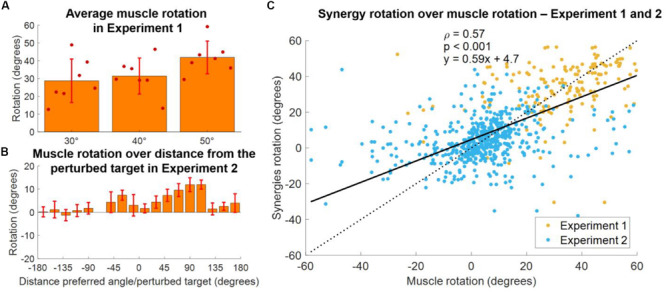
Comparison between synergies and muscle rotations. (A) Average (across muscles) rotation of the muscles at AD3 for all three macro-blocks of Experiment 1. Individual dots represent the average value for each subject in each experiment. Bars and whiskers represent the average and standard deviations across subjects. Muscle rotation was calculated using the same procedure employed for the calculation of the synergy rotation. (B) Distribution of average (across subjects, targets and muscles) muscles rotations values as a function of the distance between the preferred angles of the muscles and the perturbed targets for Experiment 2. Bars represent average values, whiskers standard deviations. (C) Synergies rotations over the rotations of the muscles contributing to each synergy (data of both experiments pooled together). A muscle was considered to contribute to a synergy if its weight in the synergy was above >0.4. The solid black line represents the linear fit between synergies and muscles rotations (values of the fit are presented in the plot, together with the p coefficient). The dotted line represents the fit relative to a perfect correspondence between muscles and synergies rotations.